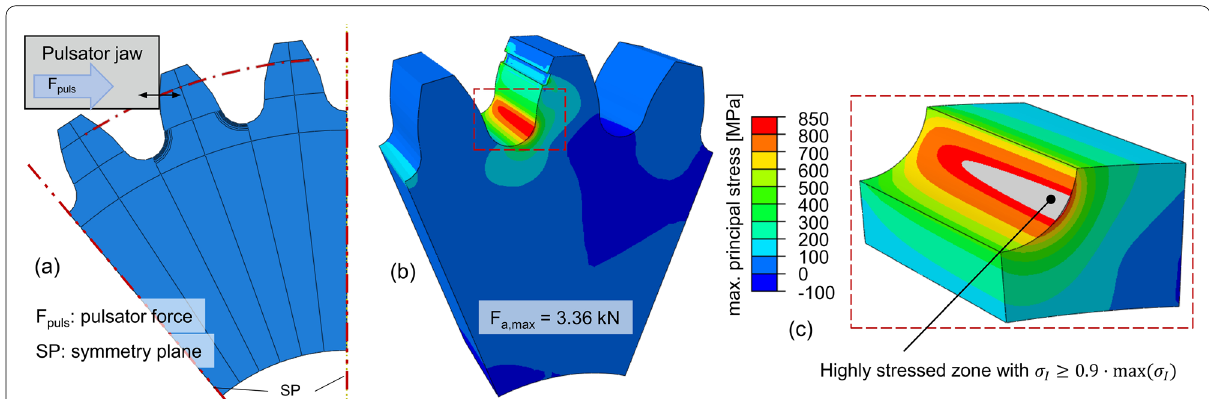
Figure 15 Determination of the highly stressed volume by tooth root bending: a pulsator test setup, b first principal stress in the tooth root, c visualization of the highly stressed zone